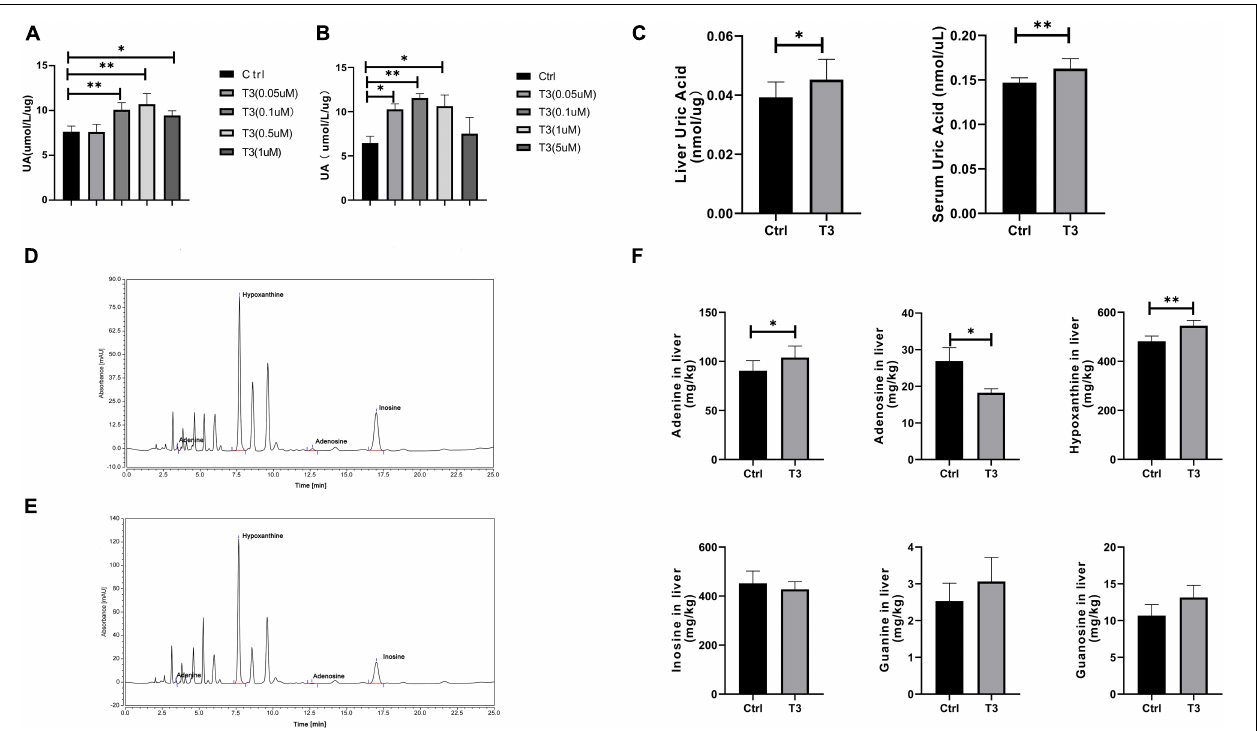
FIGURE 2 | Urate levels in culture supernatant of HepG2 cells (A) and Hep 1-6 cells (B) at 48 h after treatment. (C) Urate levels in mouse liver and serum samples. Liquid chromatography analysis of adenosine, adenine, hypoxanthine, and inosine in the control group (D) and T3 treatment group (E) . (F) Levels of adenosine, adenine, guanosine, guanine, hypoxanthine, and inosine in the livers of control and T3 treatment group mice ( ∗ P < 0.05; ∗∗ P <